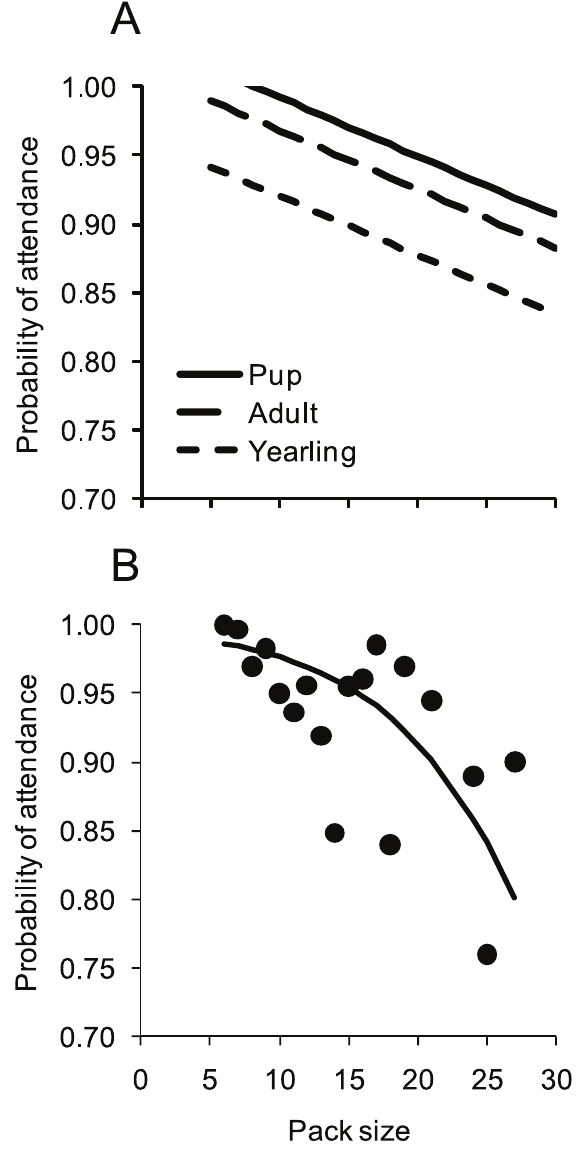
Figure 6. The influence of pack size and wolf age on the probability of carcass attendance during winter. Panel (A) depicts predictions for general linear model that included the influence of pack size and wolf age. For panel (B), the curve represents the linear regression fit to a logit transformation of mean probability of attendance and then back transformed. The regression also weighted each observation according to each observation’s sample size. The model is y =(1 + exp[–{5.10–0.14 x }]) 2 1 with R 2 =0.43 and P =0.003.